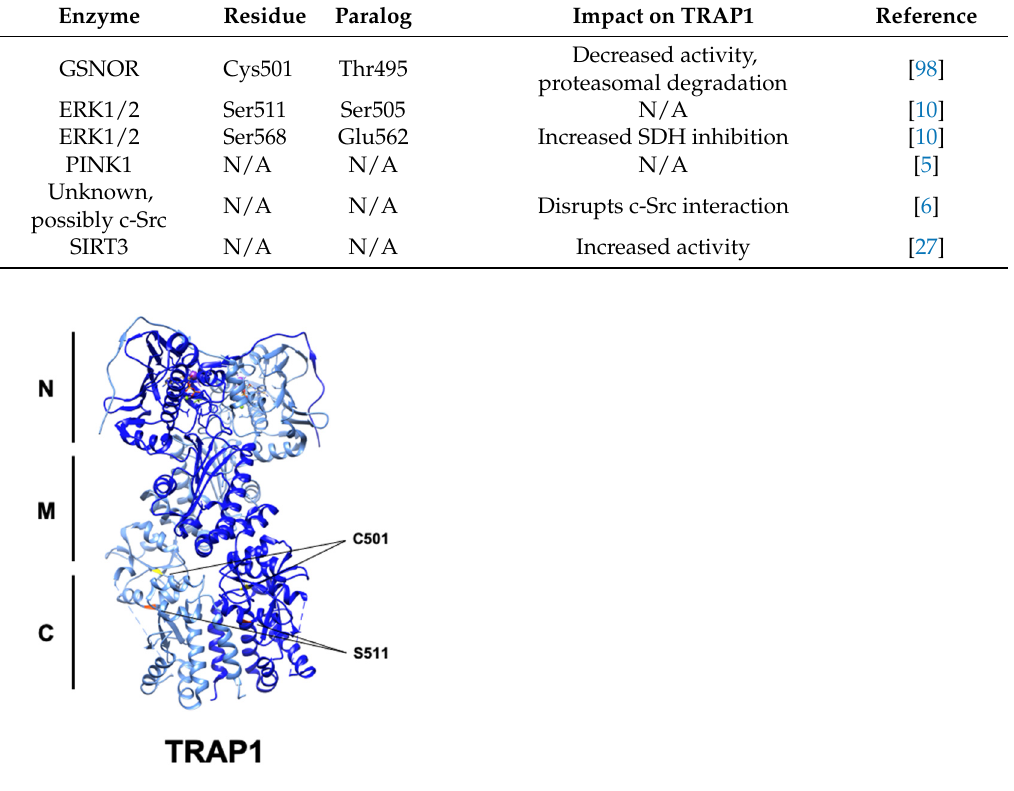
Figure 4. Ribbon structure of human TRAP1 (PDB: 6xg6) with known PTM sites. C501 (yellow) and S511 (red) are highlighted, while S568 is absent.